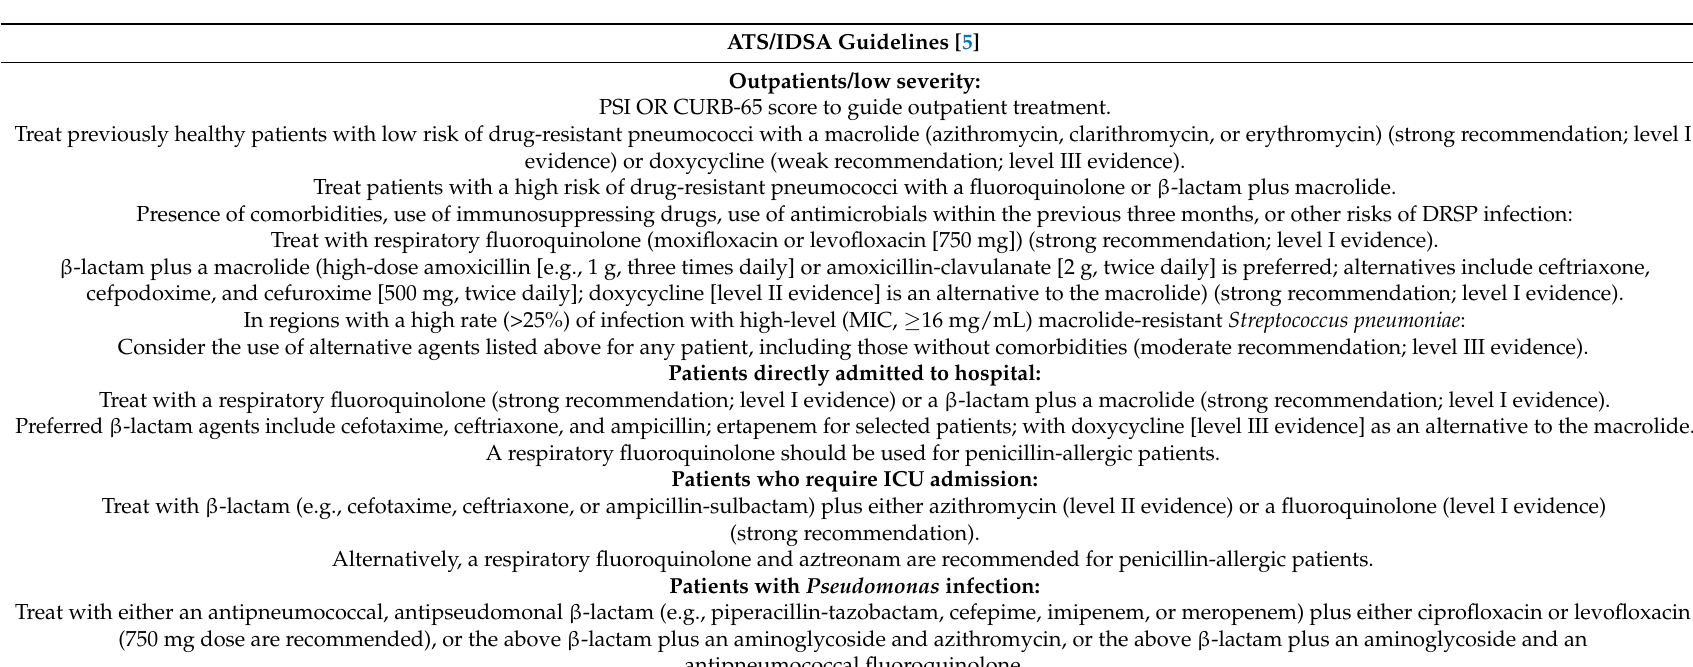
Table 5. ATS/IDSA Guidelines for the Management and Treatment of Community-Acquired Pneumonia. ATS/IDSA Guidelines [5] Outpatients/low severity: PSI OR CURB-65 score to guide outpatient